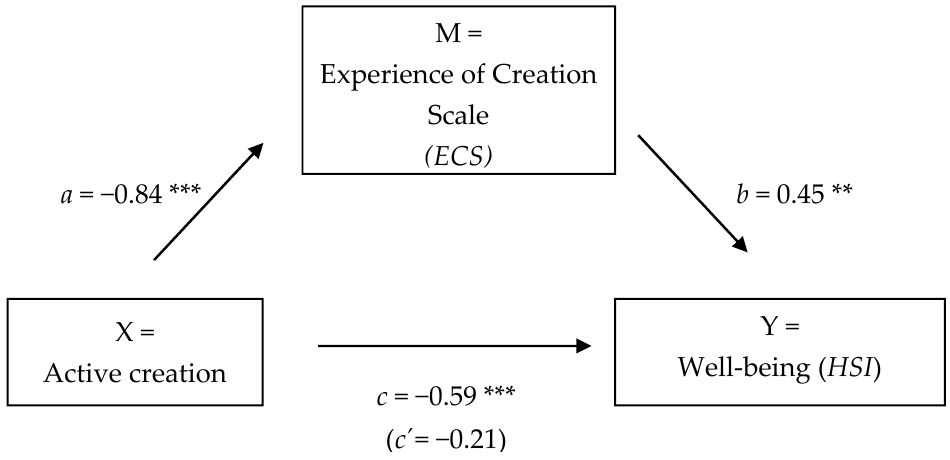
Figure 5. The effect of active creation on well-being ( HSI ) was mediated by the Experience of Creation Scale ( ECS ; full mediation). Note: * p < 0.05, ** p < 0.01, *** p < 0.001, HSI = Heidelberg State Inventory [16]. Table 6. Coefficients for the effect of active creation on self-efficacy ( GSE ).